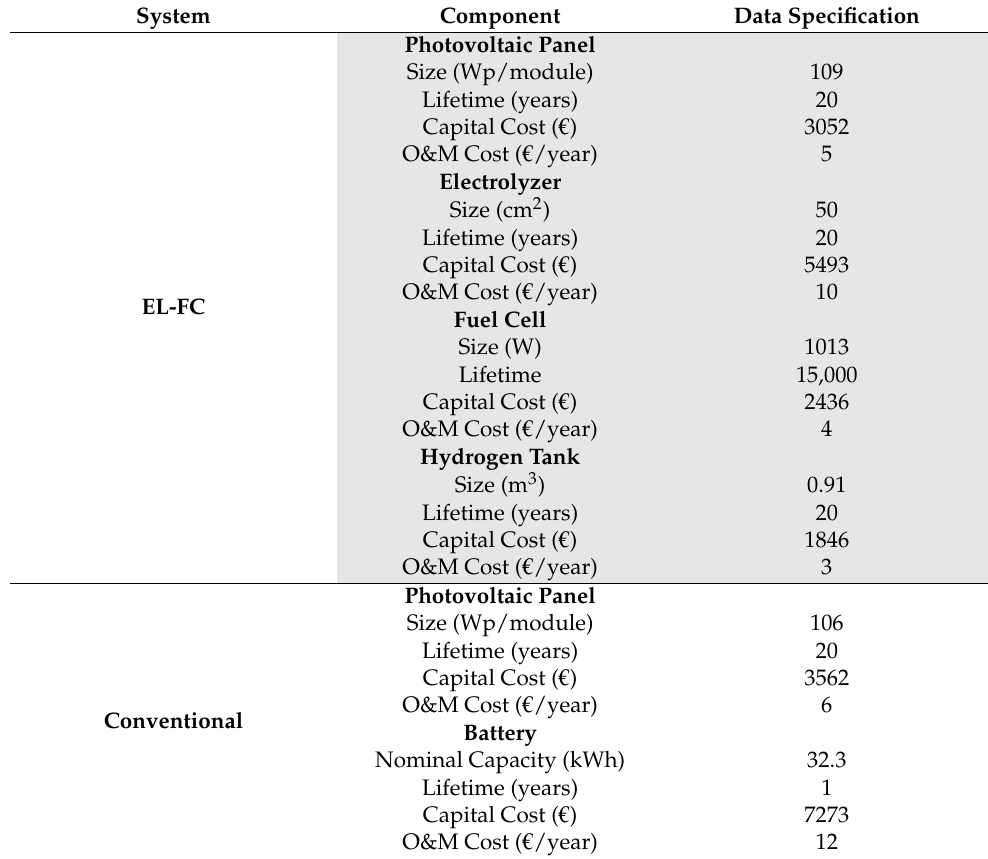
Table 2. Economic and technical specification for the components of EL-FC/conventional